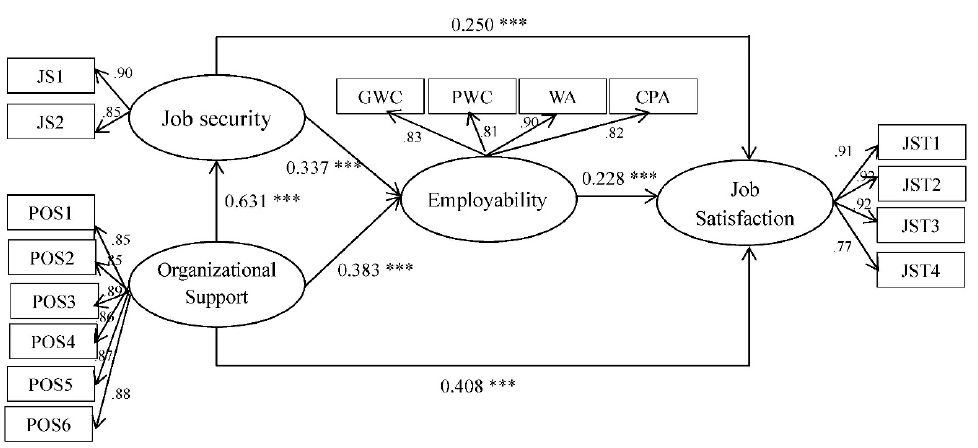
Figure 2. Structural model on Taiwanese sample. Note: *** p < 0.001. JST means “Job satisfaction”, JS means “Job Security”